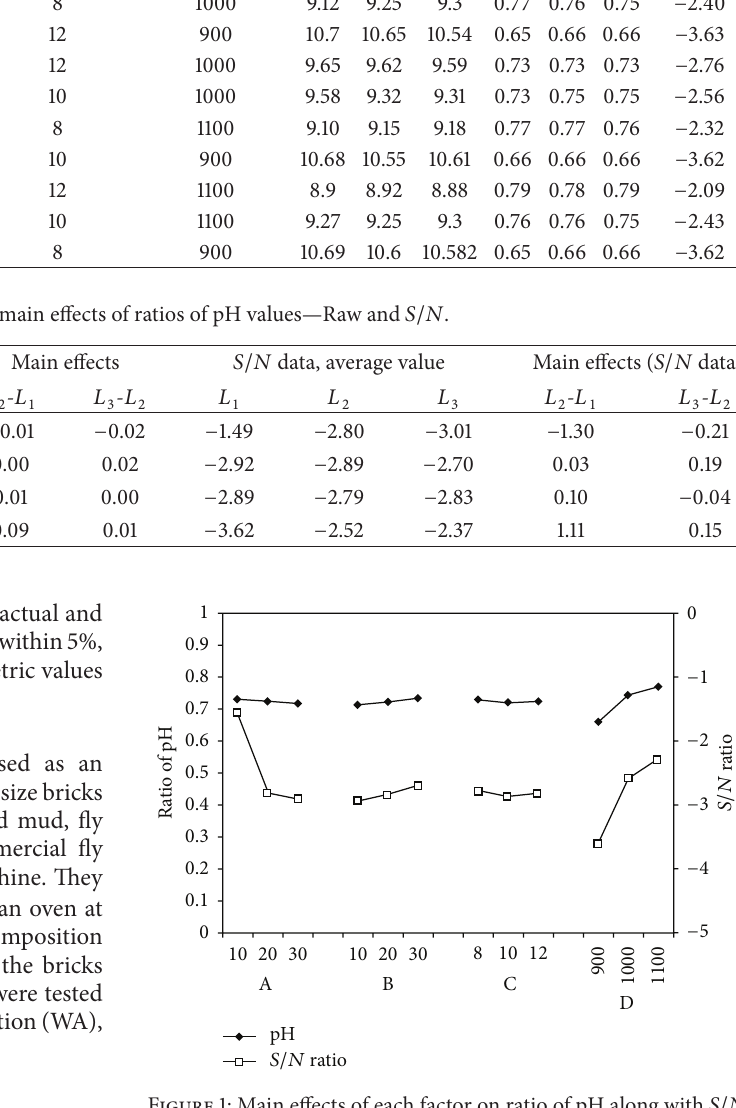
Figure 1: Main effects of each factor on ratio of pH along with 𝑆/𝑁 ratio of treated red mud slurry (ANOVA analysis). A: wt. of red mud (g); B: wt. of silicate material (g); C: vol of water (mL); D: temp. ( ∘